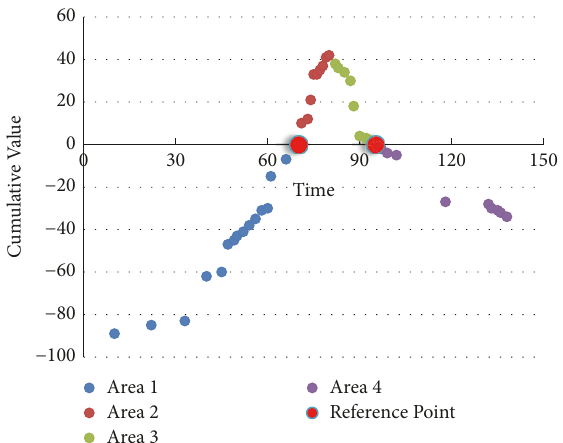
Figure 3: Departure time preference of different genders.